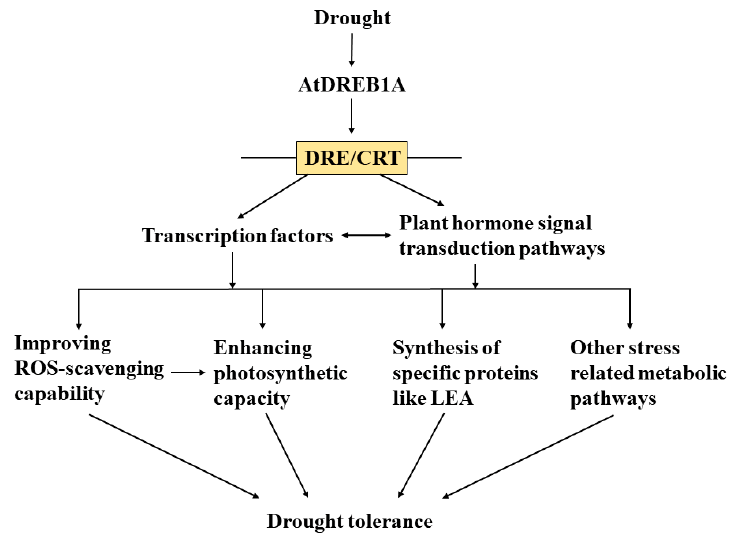
Figure 10. Proposed model for AtDREB1A function during drought stress.